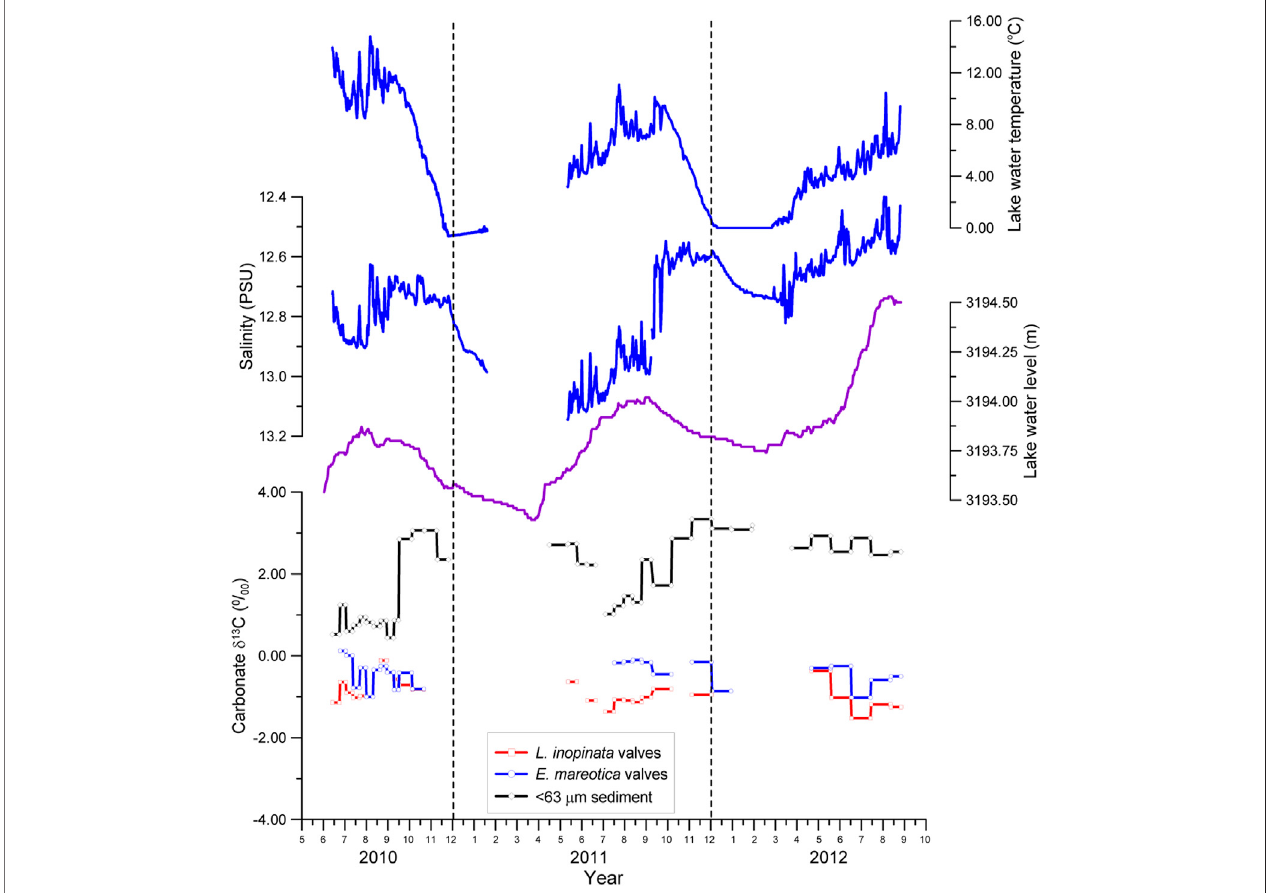
FIGURE5| Seasonalandinterannualvariationsin δ 13 Cratiosfortwospeciesofadultostracodshells( L.inopinata and E.mareotica )andcarbonatesofthe < 63 μ m fraction in sediment from July 2010 to September 2012, along with water temperature, salinity, and water level of Lake Qinghai.